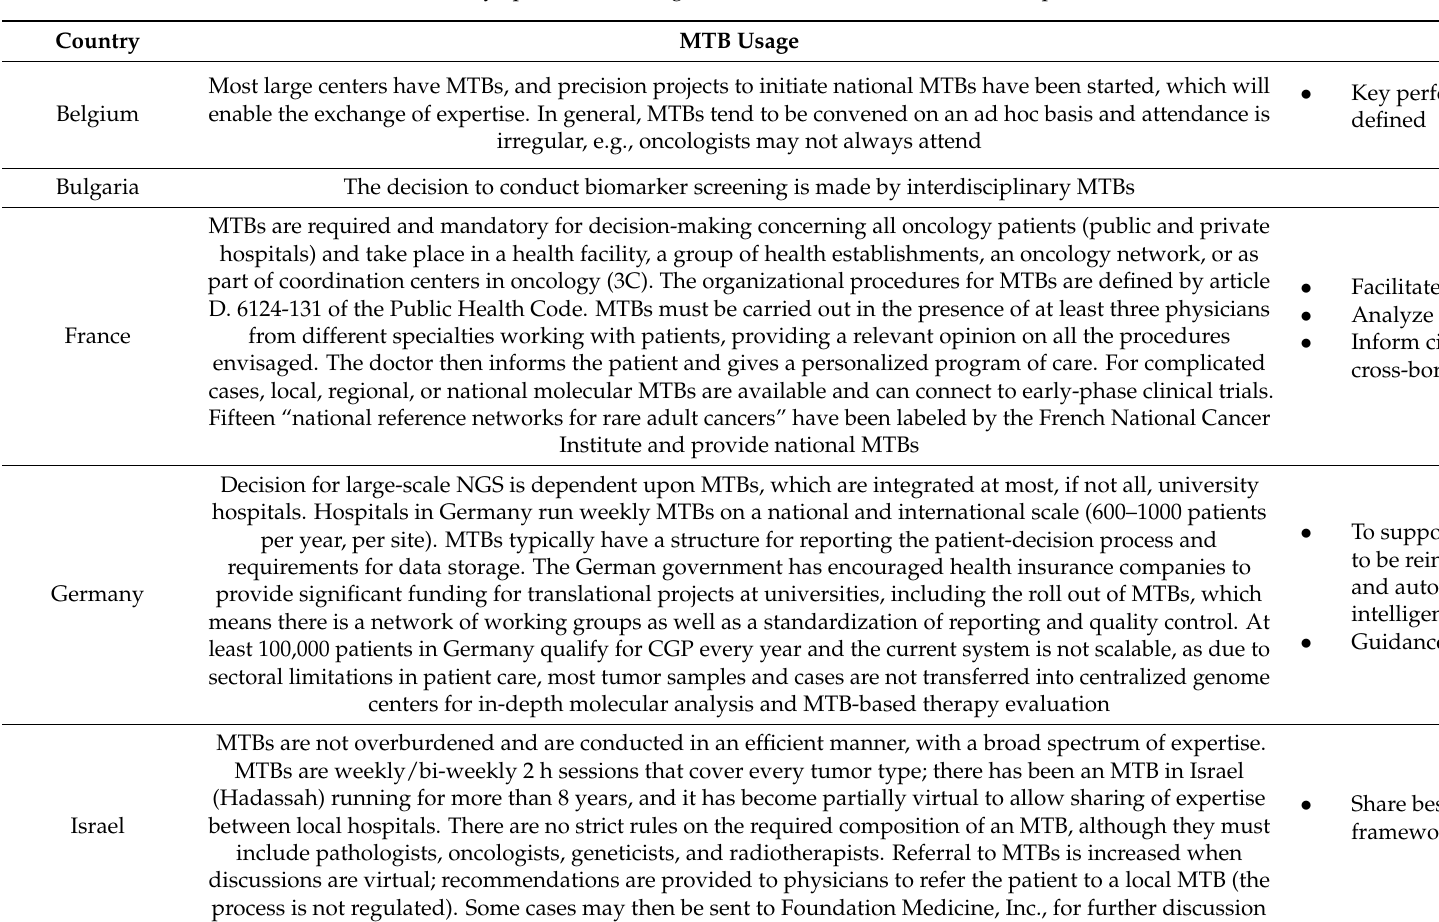
Table 1. Country-specific MTB usage and recommendations across